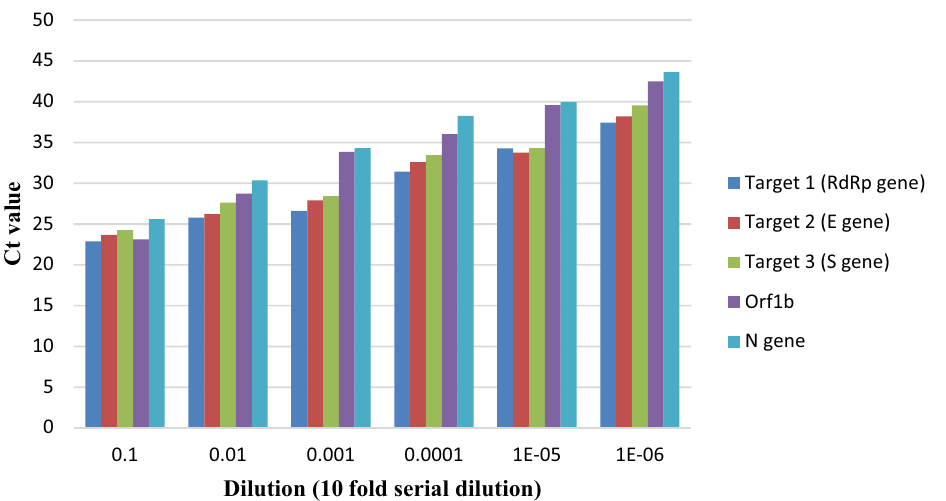
Figure 12. Comparision of average C t value obtained at different dilution (tenfold serially diluted) with In house RT-PCR assay and Meril COVID-19 RT-PCR kit. Although efficient amplification was obtained upto 10 –6 dilution with both the assay, C t value ≥